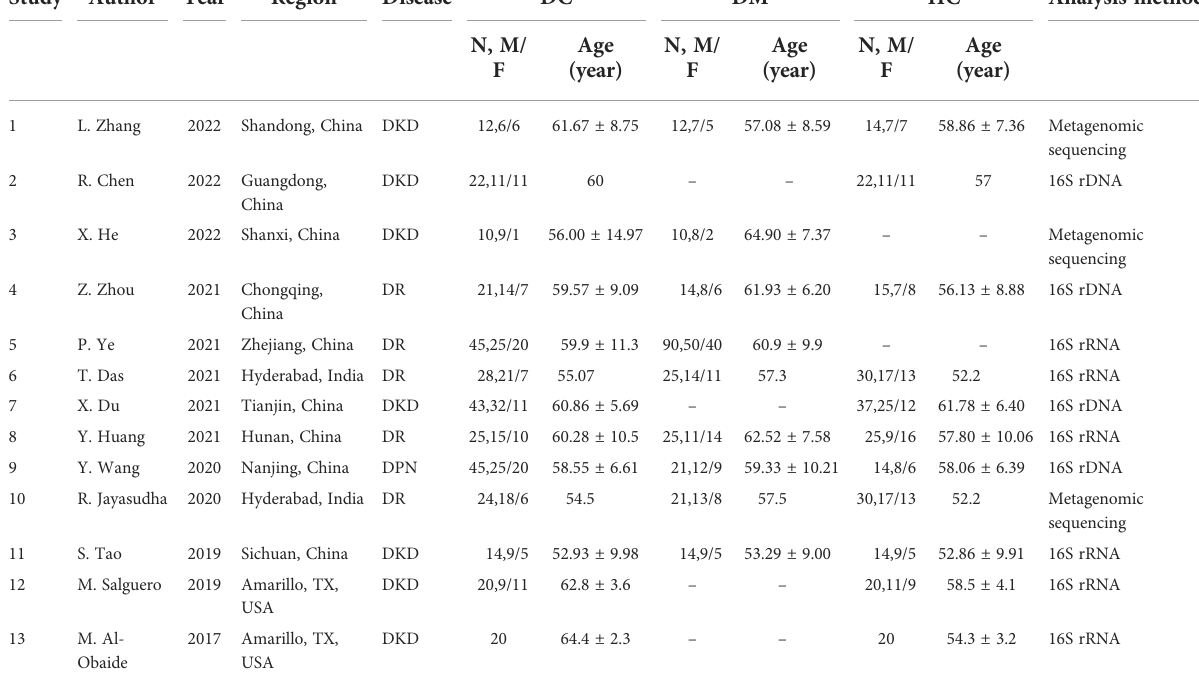
TABLE 1 Characteristics of the included